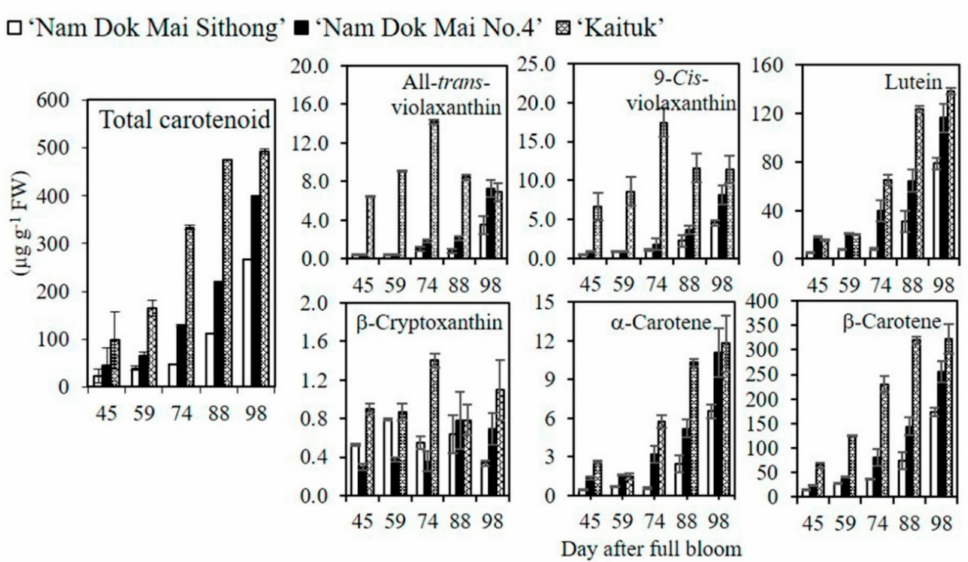
Figure 5. Changes in carotenoid content and compositions in peel of mango fruit cv. ‘Nam Dok Mai Sithong’, ‘Nam Dok Mai No. 4’ and ‘Kaituk’ during fruit development (45–88 days) and full ripening stage (98 days). The vertical bars represent the means with SE for three